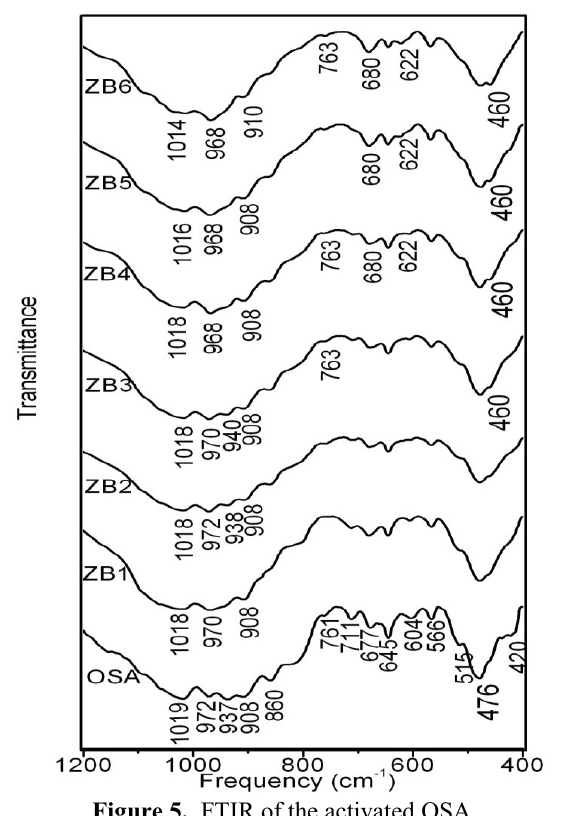
Figure 5. FTIR of the activated